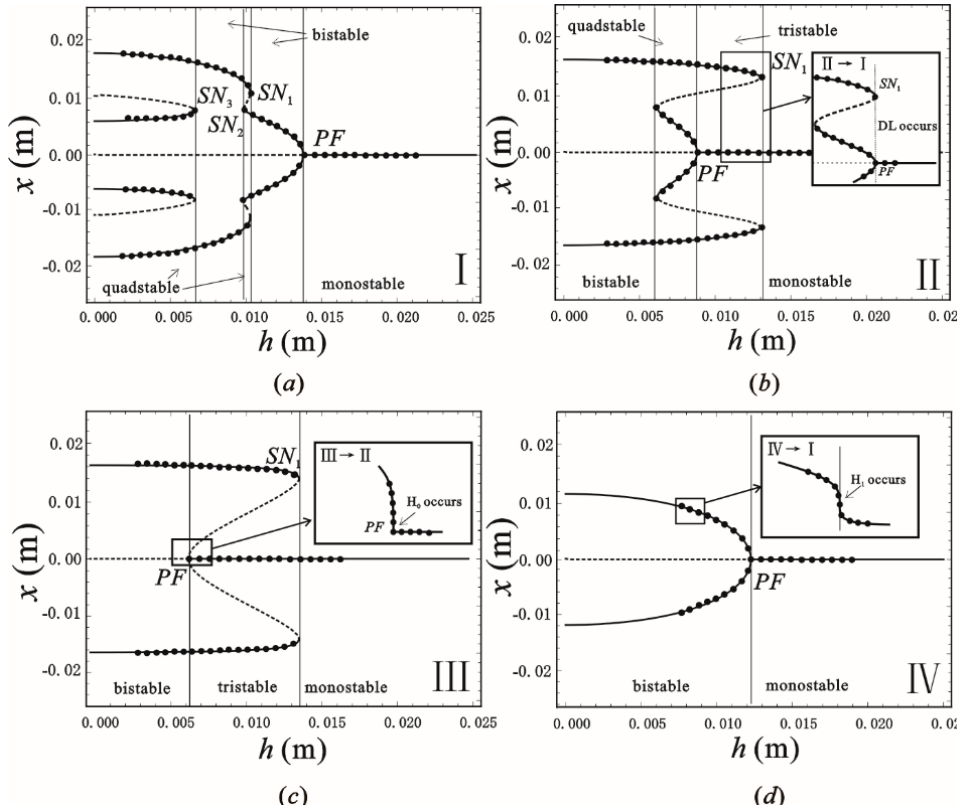
Figure 3. Bifurcation diagrams of the equilibrium solutions in four persistent regions, where block diagrams are critical cases of H 0 , H 1 and DL and scattered points represent numerical results. ( a ) region I; ( b ) region II; ( c ) region III; ( d ) region IV.